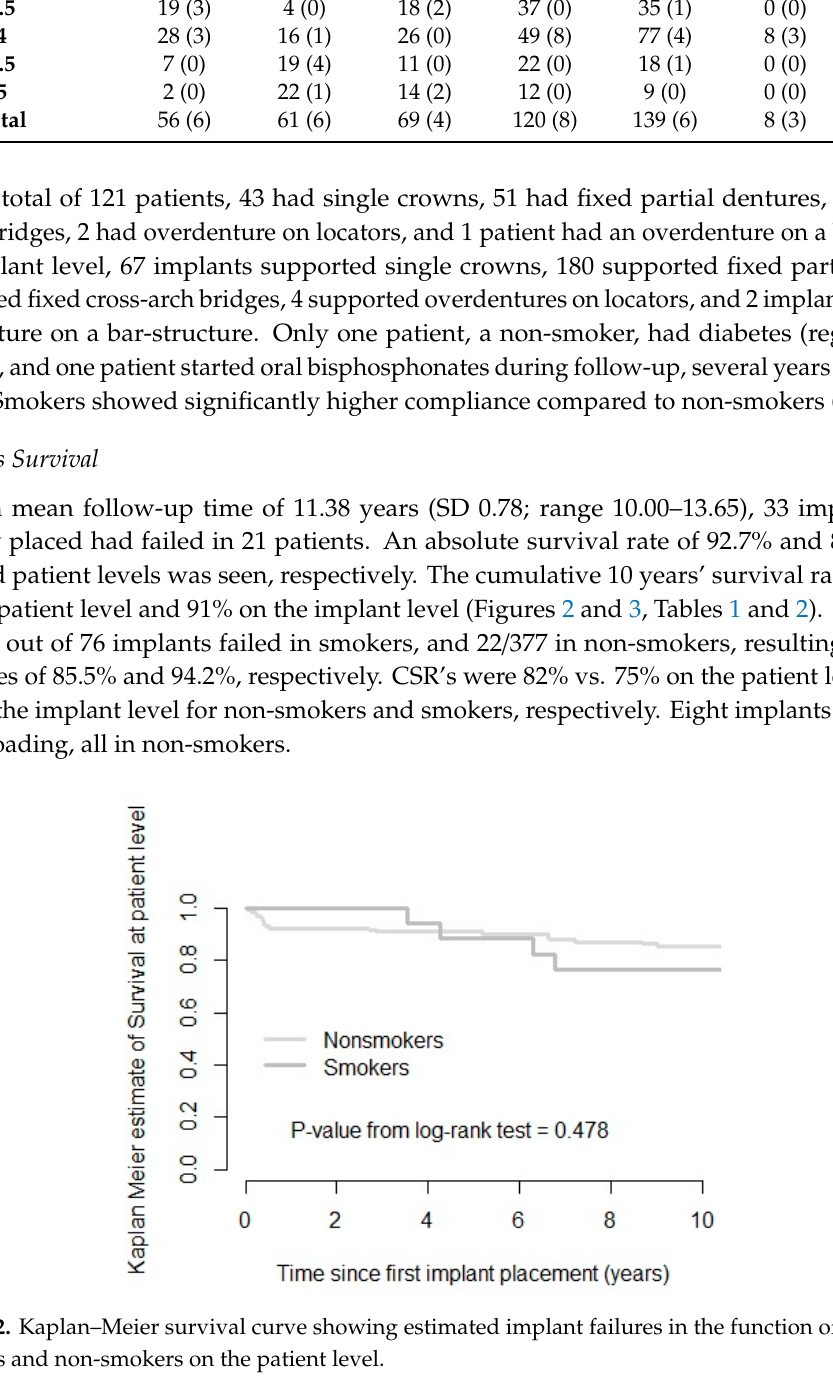
Figure 3. Kaplan–Meier survival curve showing estimated implant failures in the function of time for smokers and non-smokers on the implant level.